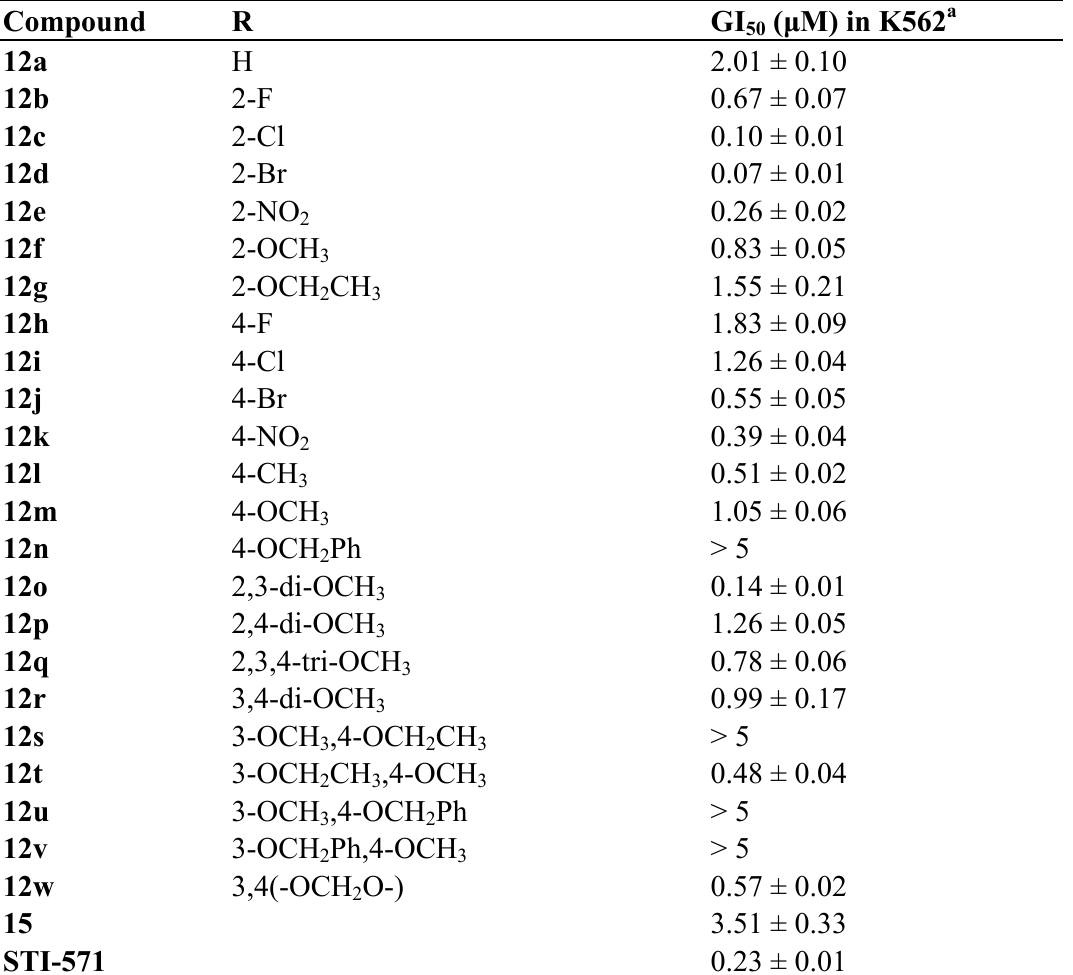
Table 1. The substituents of target compounds and their antiproliferative effects in K562 cells.